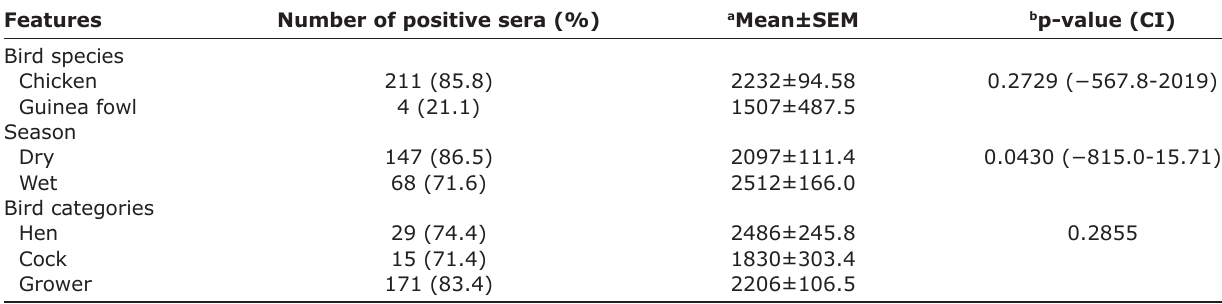
Table-4: IBDV antibody titer distribution in local chickens and Guinea fowls using ELISA.